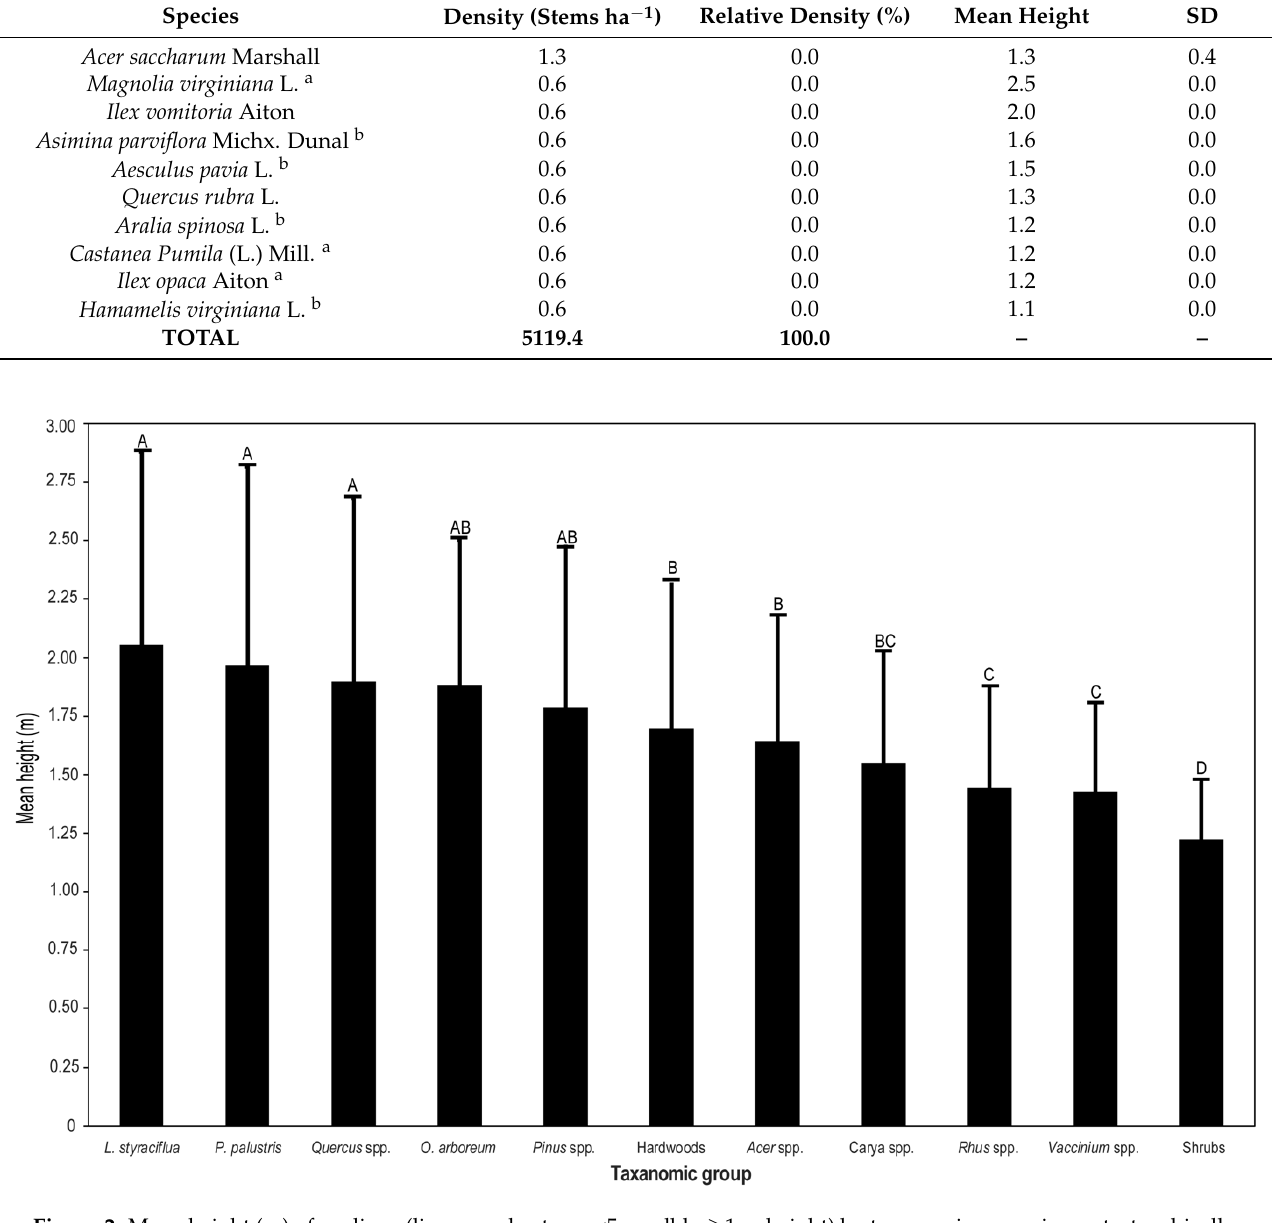
Figure 2. Mean height (m) of saplings (live, woody stems <5 cm dbh, ≥ 1 m height) by taxonomic group in a catastrophically disturbed Pinus palustris woodland on the Oakmulgee Ranger District, Talladega National Forest, Alabama, USA. Species are ranked by total relative density. Different letters indicate significant differences at p < 0.05.